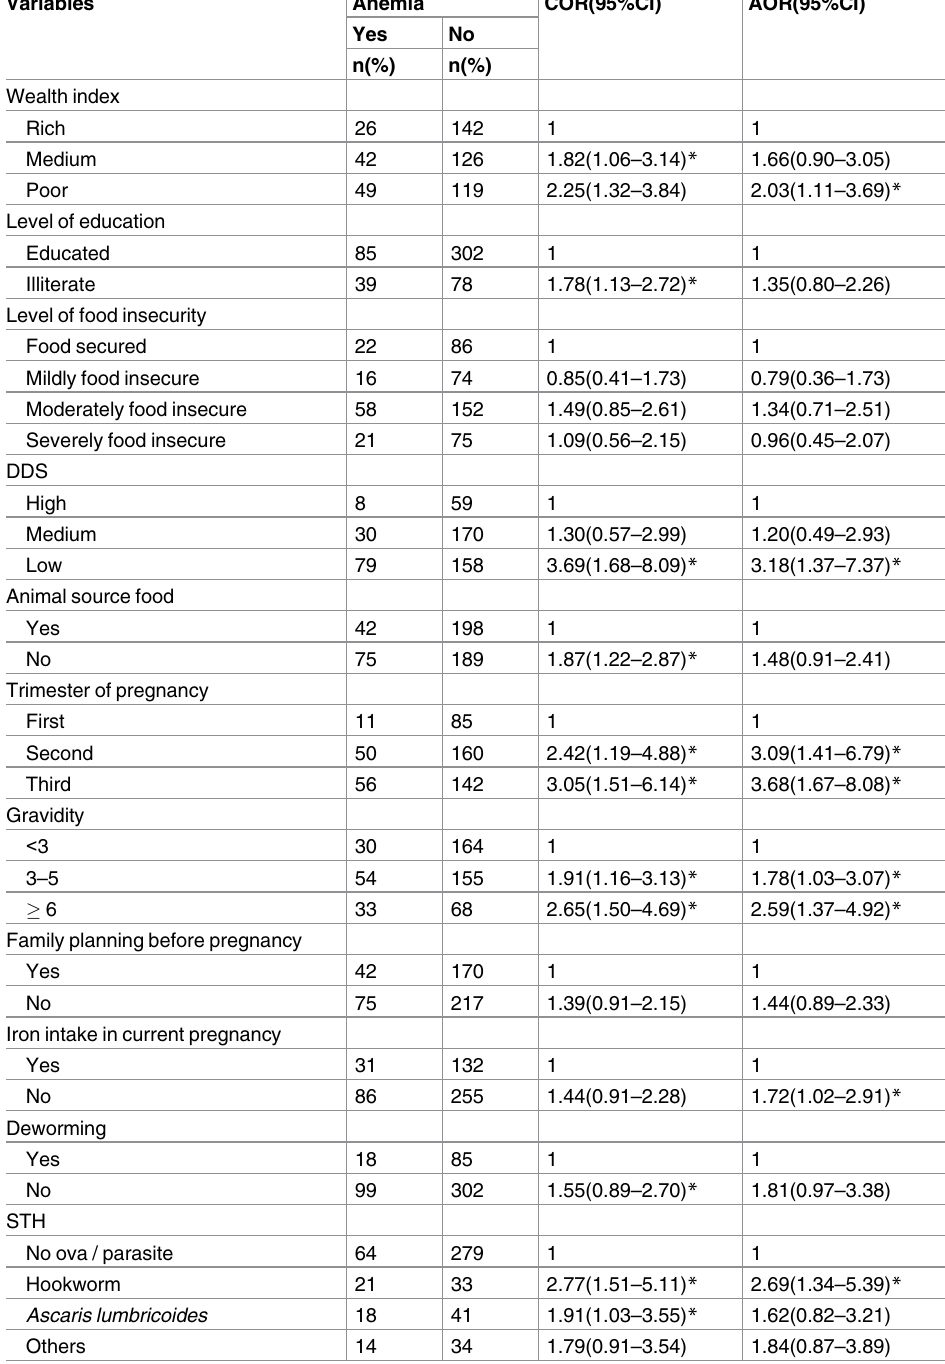
Table 3. Factors associated with anemia among pregnant women in Lemo district, Southern Ethiopia, 2015 (n =